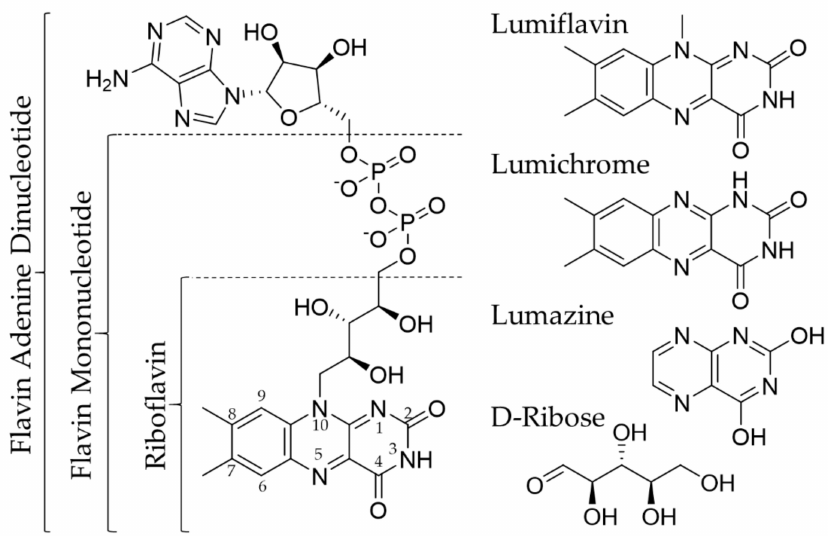
Figure 1. Chemical structures of riboflavin (RF) (with the numbering of isoalloxazine ring), Flavin Mononucleotide, Flavin Adenine Dinucleotide, Lumiflavin, Lumichrome, Lumazine, and